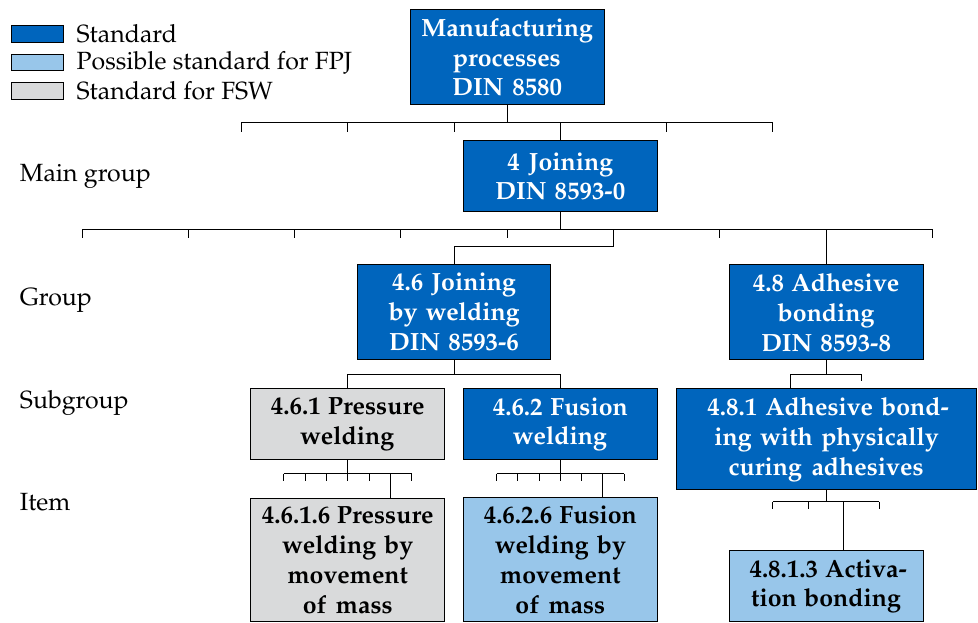
Figure 11. A recommendation for the classification of the friction press joining process according to the DIN 8580 [47] standard for manufacturing